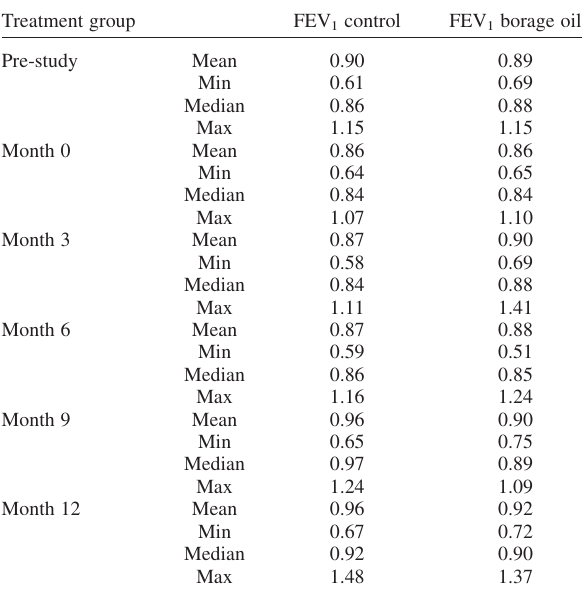
TABLE IV Quantitation of FEV